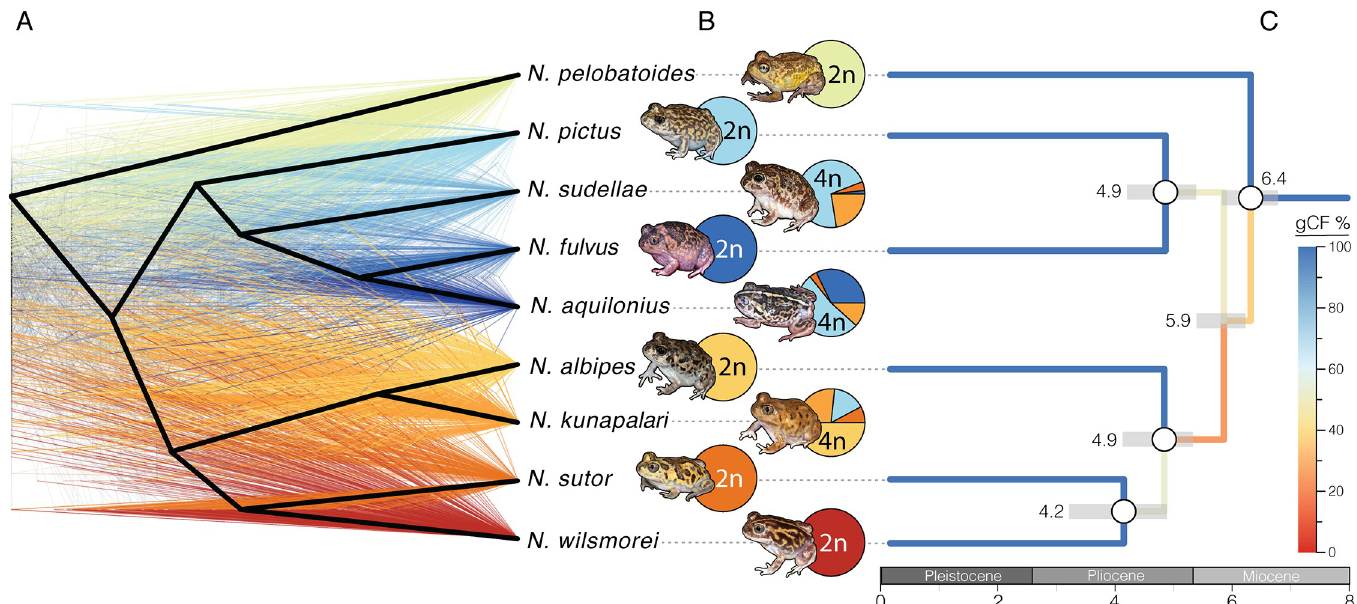
Fig 1. Independent origins of Neobatrachus tetraploids and high levels of reticulation. (A) Gene trees, colored by clade, for 361 nuclear loci based on 2 individuals per species show considerable incongruence and differ from the species trees (bold black topology). Conflict between gene tree clusters (S3 Fig) and the nuclear species tree suggest non-bifurcating relationships between the species. (B) Pie charts represent summarised admixture proportions for each species (summing assignments for each individual, S1 Fig, Fig 2) at optimal clustering with K = 7. Tetraploids ( N . sudellae , N . aquilonius and N . kunapalari ) show highly admixed ancestries. (C) Dated diploid- only species tree. Colors represent consistency levels between gene genealogies with red being most conflicted and blue most consistent. Grey bars represent 95% confidence intervals on the ages of nodes, noted in millions of years before present.